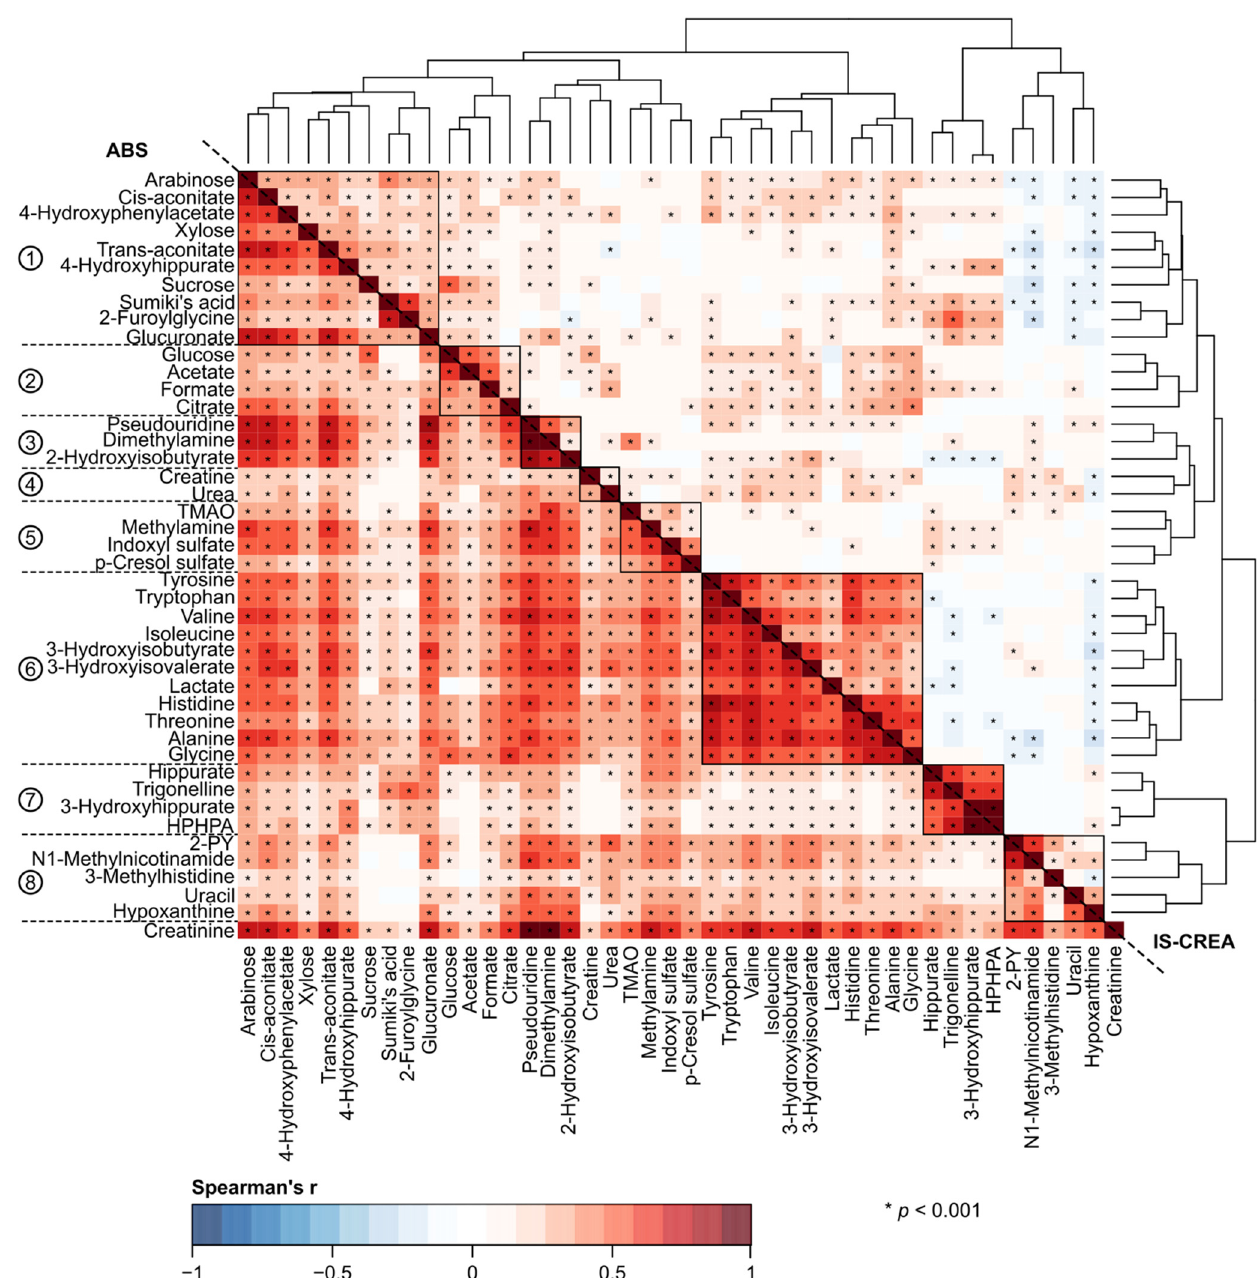
Figure 1. The urinary metabolite–metabolite associations as indicated by Spearman’s rank correla- tions adjusted for sex. The down-left triangle shows results for the absolute urinary metabolite con- centrations (i.e., no normalization applied) and the top-right triangle for the creatinine normaliza- tion (IS-CREA). Two-dimensional hierarchical clustering was applied to organize the IS-CREA heat map to make detailed comparisons of the metabolite–metabolite associations feasible between the different normalization schemes. All heat maps are presented in the same order of metabolites with creatinine added to the last row. The reference metabolite correlations are left blank in their corre- sponding heat maps. As a by-product of the hierarchical clustering, eight urinary metabolite clusters were identified as numbered on the left and detailed in the Results section. Abbreviations: TMAO, trimethylamine N-oxide; HPHPA, 3-(3-hydroxyphenyl)-3-hydroxypropanoate; 2-PY, N1-Methyl-2- pyridone-5-carboxamide.